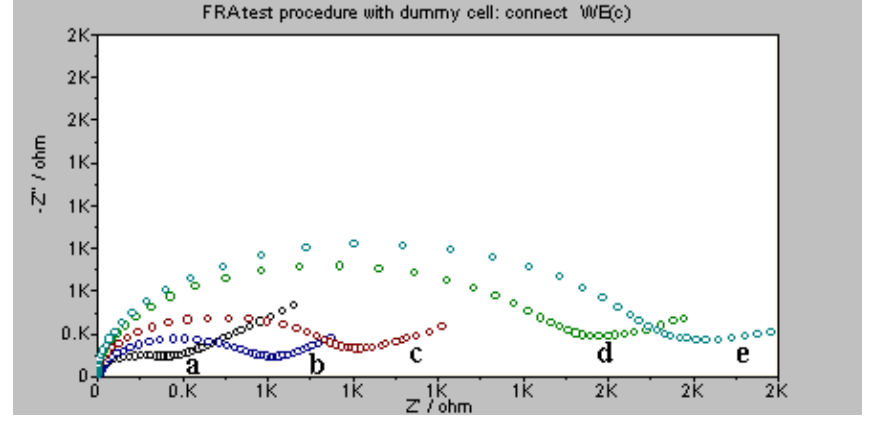
vs. Z ) of electrochemical impedance measurements Figure 6. Nyquist diagram (Z im re corresponding to the following: (a) the bare electrode; (b) 2.0 μ M thiolated probe modified electrode; (c) 1 mM 6-mercaptohexanol modified electrode; (d) after the hybridization with 2×10 -9 M positive control; (e) after the signal amplification with 0.6 mg/mL Au nanoparticles. All impedance measurements were performed in 0.17 M PBS buffer, pH